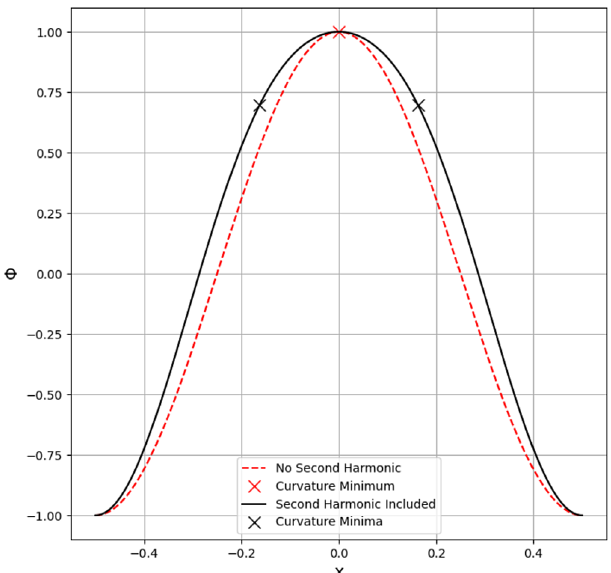
Fig. 7. The phase perturbations associated with the simple sine wave perturbation given by equation (2) (red dashed line) and the perturbation given by equation (10) (black solid line). The minima of curvature for both curves are also marked. Both are normalised to an amplitude of 1 and wavelength of 1 and have a = 0. The harmonic has a relative amplitude of A = (cid:3)